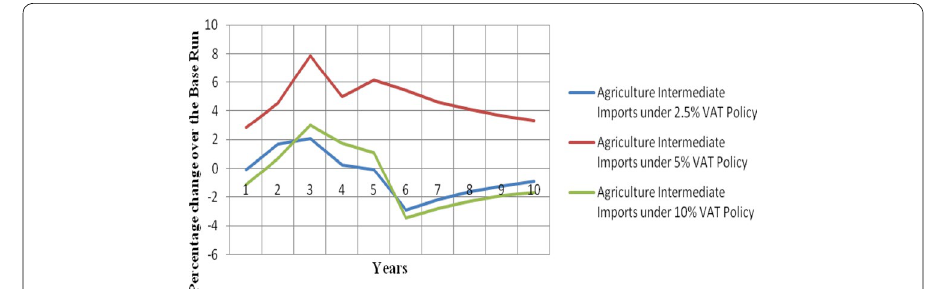
Fig. 39 Changes in agricultural intermediate imports under varying VAT rates